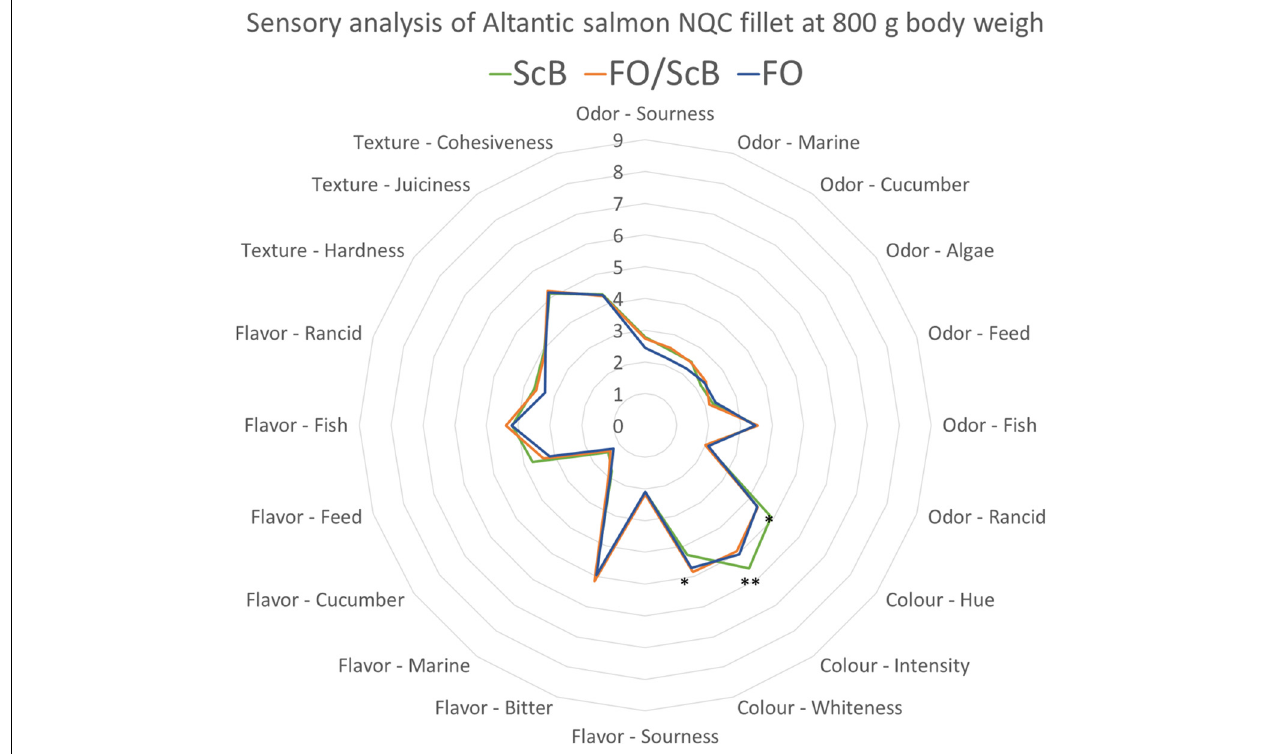
FIGURE 1 | Sensory analysis. Parr-post smolt – 0.8 kg mean body weight Atlantic salmon. Comparisons of mean values (Tukey’s test) of evaluation on Atlantic salmon raw filet samples for odor and color and heated (cooked) filets for taste, flavor, and texture at 800 g mean body weight ( ∗ P < 0.05; ∗∗ P <